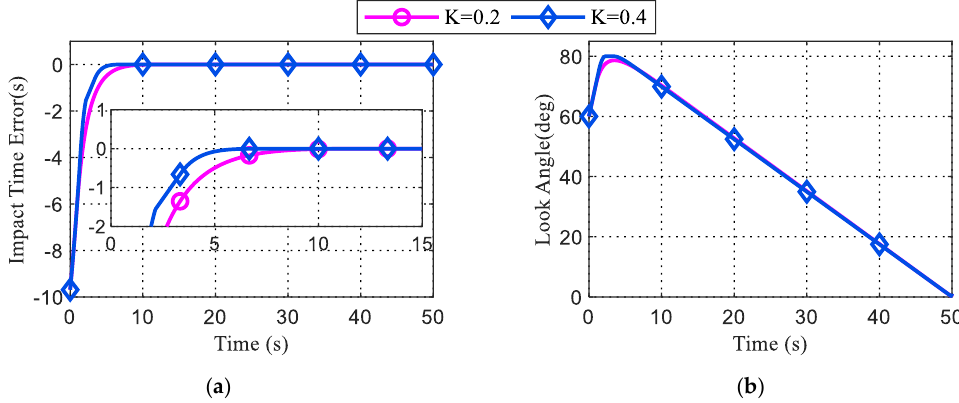
Figure 6. The results for different values of K under T d = 50 s. ( a ) Trajectories; ( b ) Lateral accelerations.